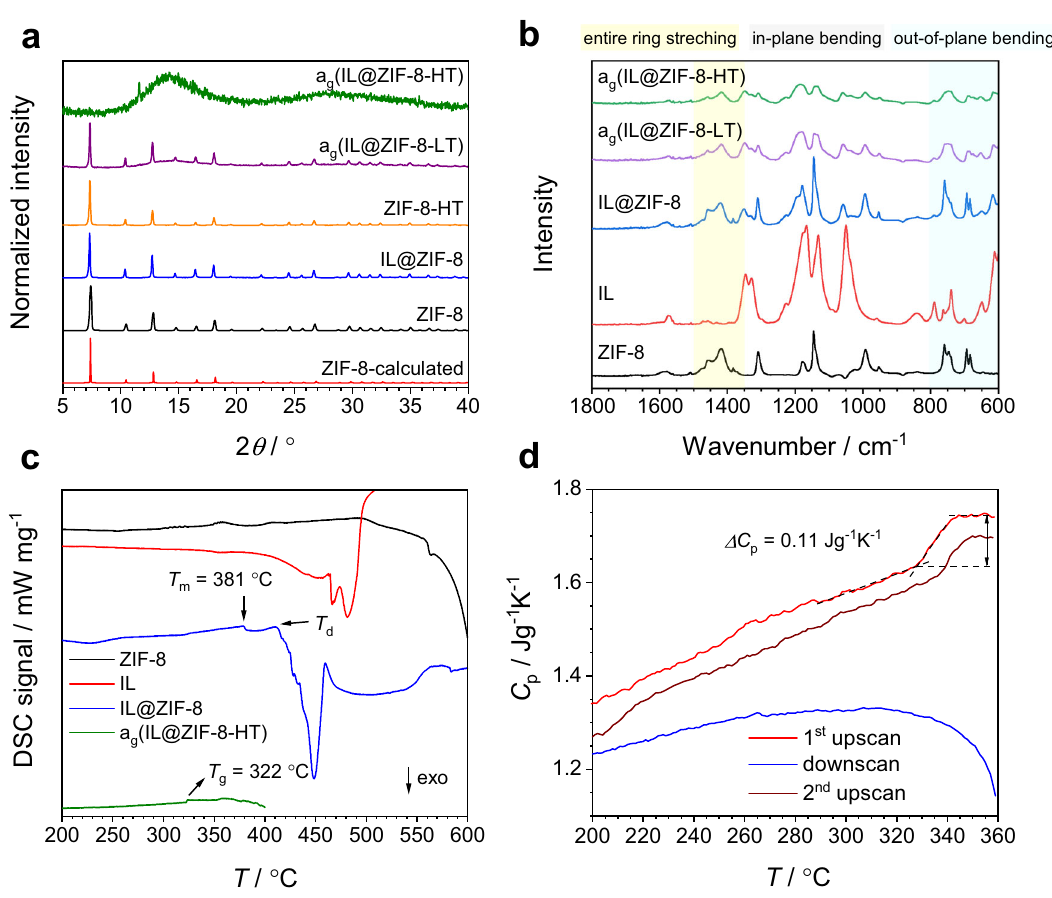
Fig. 2 Structural characterization, enthalpic responses, and cyclic C p scan. a XRD patterns of ZIF-8, IL@ZIF-8 crystalline composite, a g (IL@ZIF-8-LT), and a g (IL@ZIF-8-HT) samples. Crystallographic data were taken from literature 25 . b FTIR spectra obtained for ZIF-8, IL, crystalline IL@ZIF-8 composite, a g (IL@ZIF-8-LT), and a g (IL@ZIF-8-HT). c DSC scans of ZIF-8, IL, IL@ZIF-8, and a g (IL@ZIF-8-HT) samples with a heating rate of 5 °C·min − 1 . T m and T d are indicated as offset temperatures of the melting peak and onset temperature of decomposition of IL@ZIF-8, respectively. T g is de fi ned as the onset